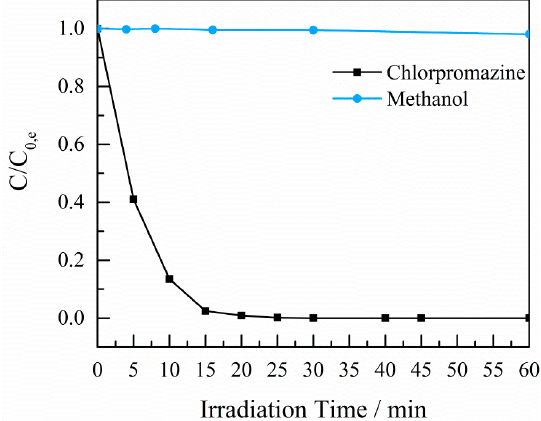
Figure 7. Comparison of the conversion of methanol and chlorpromazine upon visible light irradiation (455 nm) in the presence of K-7000.